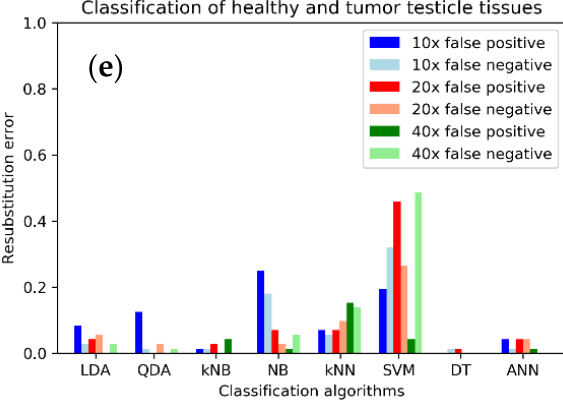
Figure 3. Re-substitution error, distinguishing the false positive and false negative rates, for each tissue type, classifier and magnification: ( a ) Brain tissue; ( b ) Ganglion tissue; ( c ) Liver tissue; ( d ) Kidney tissue; ( e ) Testicle tissue. LDA: linear discriminant analysis; QDA: quadratic discriminant analysis; NB: Naïve Bayes; kNB: kernel Naïve Bayes; kNN: k-nearest neighbors; SVM: support vector machine; DT: decision tree; ANN: artificial neural network.